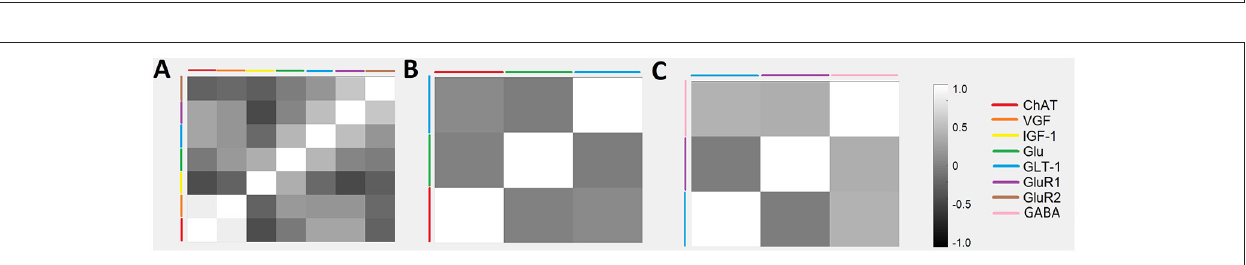
was significantly lower than GABA at pre-onset ( p =